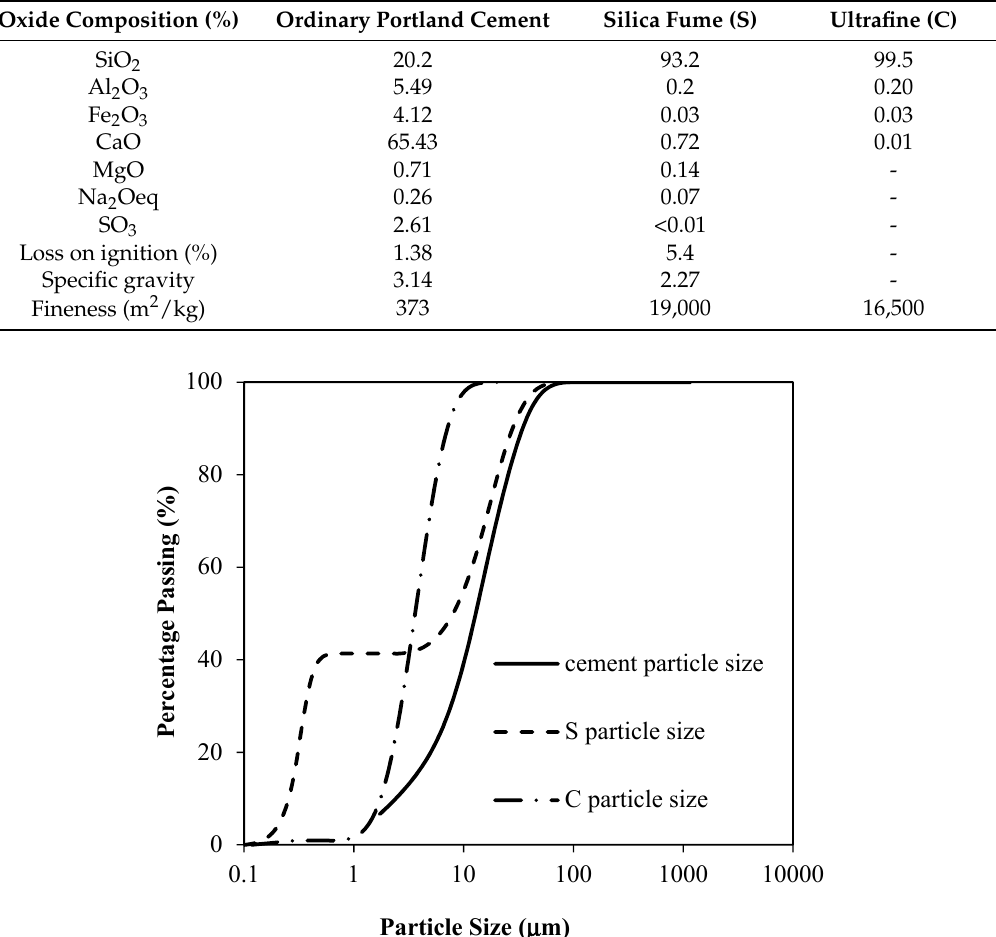
Figure 1. Particle size distribution of cement, silica fume, and quartz filler.